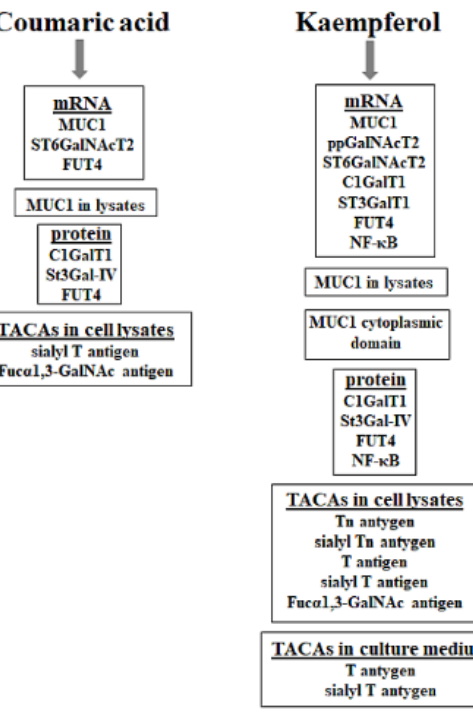
Figure 8. Summarized inhibitory effect of coumaric acid, kaempferol, astragalin and tiliroside on specific glycoforms and NF-κB in AGS gastric cancer cells.